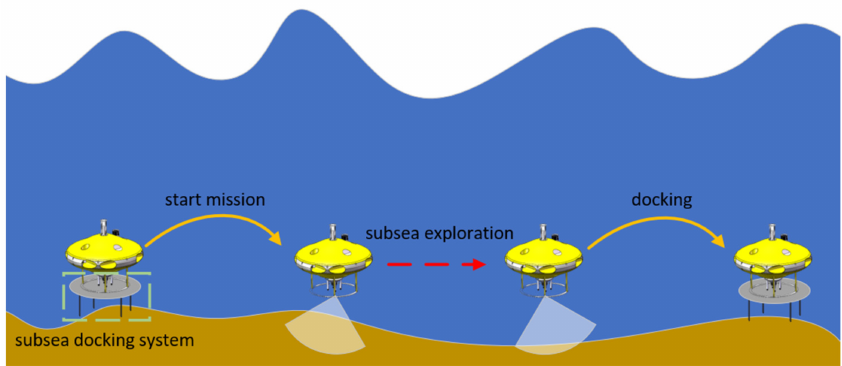
Figure 1. Work pattern of